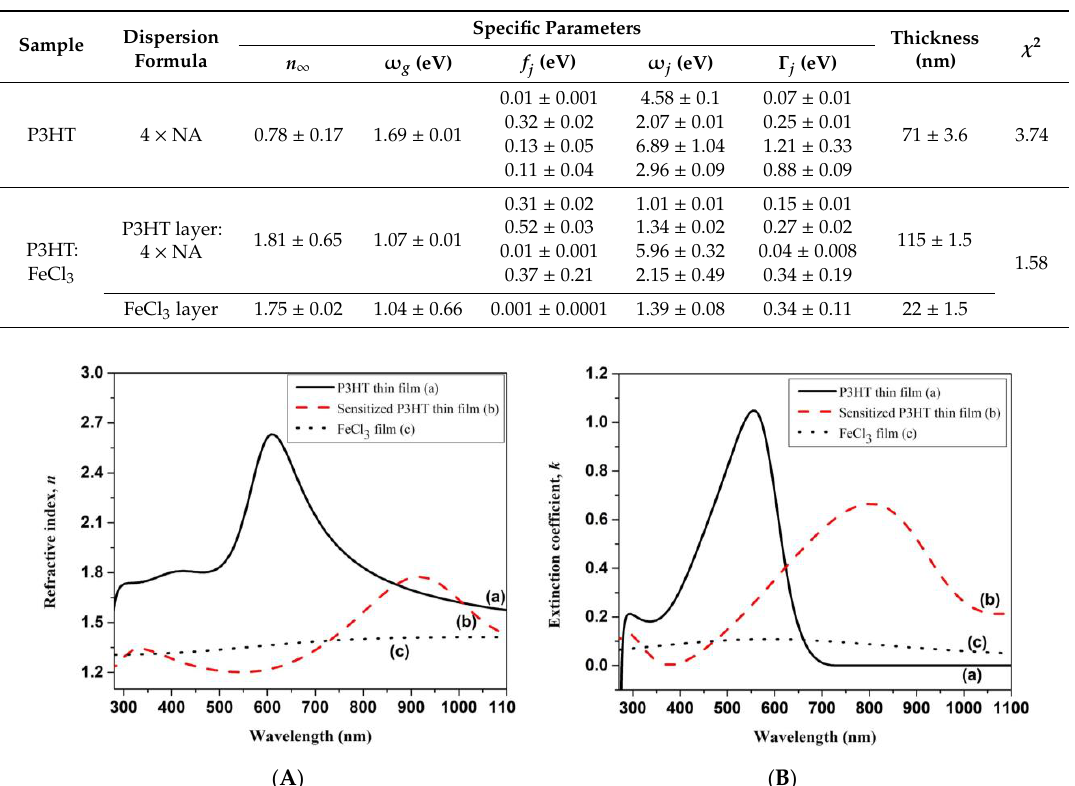
Table 1. Ellipsometric parameters used to simulate the models.